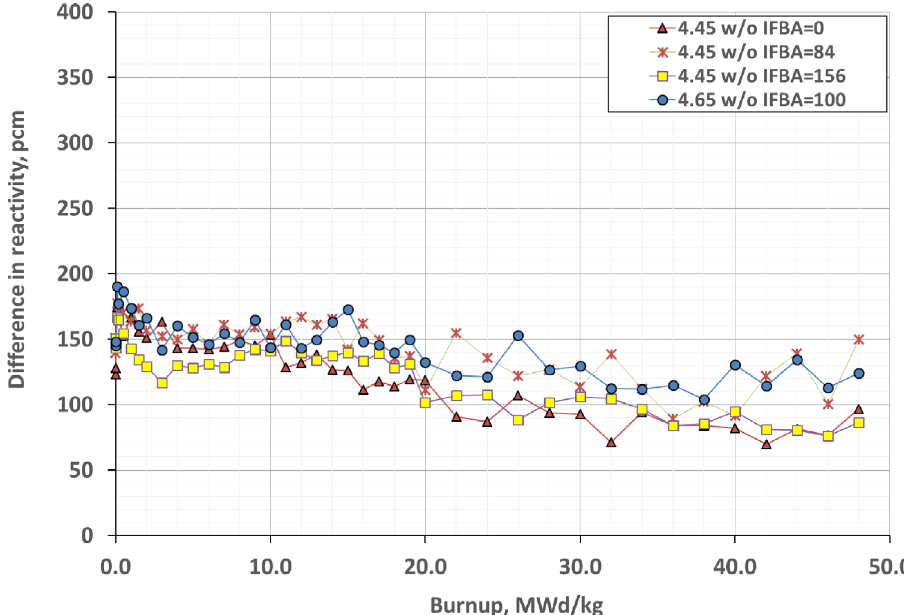
Fig. 5. Difference in reactivity (WIMS vs. Serpent) for different IFBA loading